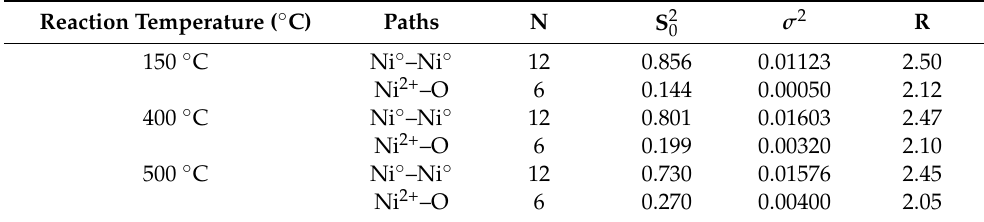
Table 2. The best fitting parameter of 15wt%Ni/ZA_5D_9h. Reaction Temperature ( ◦